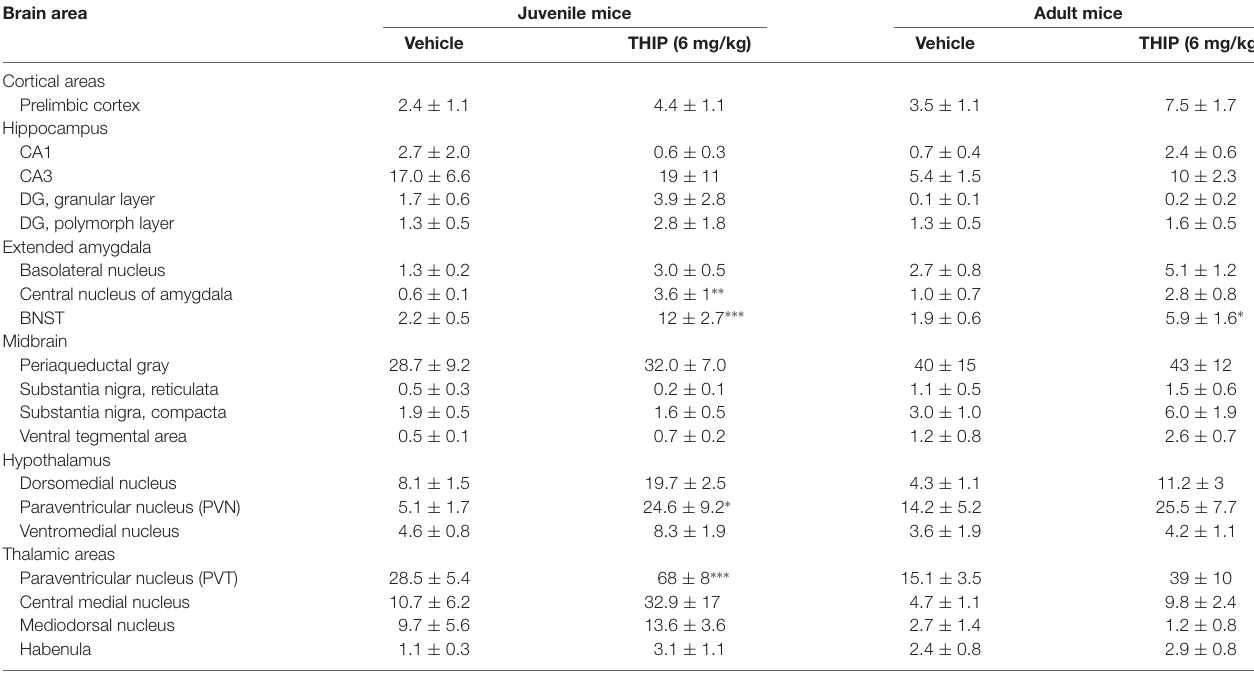
TABLE 2 | Brain regional expression of c-Fos 2 h after THIP treatment in juvenile and adult male C57BL/6J